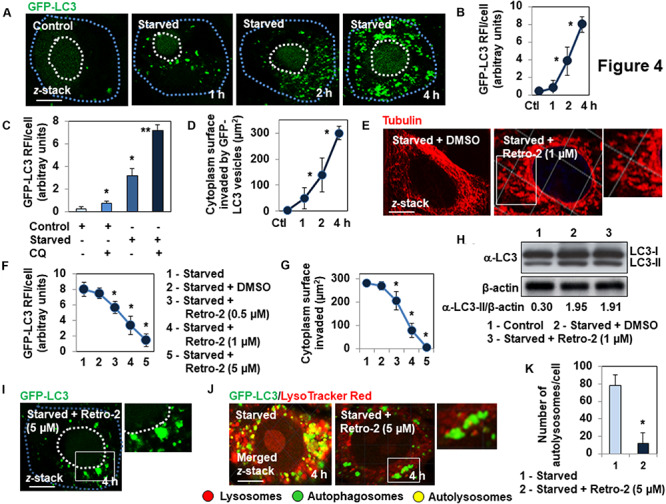
Retro-2 impairs the spreading of autophagic vesicles into the cytoplasm of nutrient-starved GFP-LC3-expressing Hela cells. (A) Representative CLSM micrographs showing the time-dependent invasion of the cytoplasm of nutrient-starved cells by GFP-LC3-positive vesicles. (B) Quantification of the GFP-LC3 relative immunofluorescence intensity (RFI), showing the increase of GFP-LC3-positive vesicles in nutrient-starved cells over a time-course. (C) Quantification of the GFP-LC3 RFI, showing the increase of GFP-LC3-positive vesicles in chloroquine (CQ)-treated Control and Starved cells compared to untreated Control and Starved cells. (D) Quantification showing the increase of cytoplasm surface invaded by GFP-LC3-positive vesicles in nutrient-starved cells over a time-course. (E) Disassembly of MT network in Retro-2-treated 4 h-nutrient-starved cells. (F) Representative CLSM micrographs showing the concentration-dependent decrease of cytoplasmic surface invaded by GFP-LC3-positive vesicles in 4 h-nutrient-starved, Retro-2-treated cells. (G) Quantification of the GFP-LC3 RFI showing the concentration-dependent decrease of GFP-LC3-positive vesicles in 4 h-nutrient starved cells treated with increasing concentrations of Retro-2. (H) Quantification of the surface of the cell cytoplasm of nutrient-starved Retro-2-treated cells invaded by GFP-LC3-positive vesicles, showing the concentration-dependent decrease of invasion. (I) A representative Western blot showing LC3 processing in control cells, 4 h-starved cells, and 4 h-starved cells treated with Retro-2 (1 μM). β-actin was monitored to ensure equal loading of the lanes. (J) Representative CLSM micrograph (Left) showing in cells loaded with LysoTracker Red, the elevated presence of autolysosomes (GFP-LC3/LysoTracker Red-positive vesicles) in the cytoplasm of a 4 h-nutrient-starved cell. Representative CLSM micrograph (Right) showing the elevated presence of very large autophagosomes (GFP-LC3-positive vesicles) mostly localizing at the perinuclear domain of a 4 h-nutrient-starved Retro-2 (1 μM)-treated cell, and the absence of cytoplasmic autolysosomes. Pearson’s correlation coefficient was –0.63 for nutrient-starved cells, indicative of classical fusion between the autophagosomes and lysosomes. Pearson’s correlation coefficient was –0.22 for Retro-2-treated nutrient-starved cells, indicative of the absence of fusion between autophagosomes and lysosomes. (K) Quantification of numbers of autolysosomes/cell showing their disappearance in the cytoplasm of 4 h-nutrient starved Retro-2-treated cells (1 μM). CLSM micrographs are representative of three separate experiments. Dotted line in white delineates cell nucleus. Dotted line in blue delineates cell cytoplasm. White boxed regions delineate the areas shown in the adjacent high-magnification images. Confocal quantification was performed using ImageJ software. Pearson’s correlation coefficient was calculated using JaCoP ImageJ software. The western blot is representative of two separate experiments in duplicate. Western blot quantification was performed using ImageJ software. Values represent the average (±SEM). Data were analyzed using the unpaired Student t-test. *P < 0.01 compared to Control (Ctl) (B–D,K). *P < 0.01 compared to Starved (G,H). **P < 0.01 compared to Starved (C).